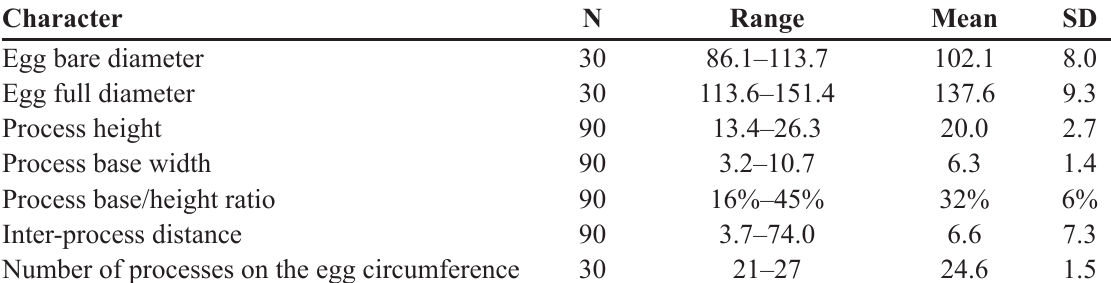
Table 8. Measurements (in µm) of selected morphological structures of the eggs of Macrobiotus cf. recens Cuénot, 1932 from the Canary Islands mounted in Hoyer’s medium. (N = number of eggs / structures measured; Range = the smallest and the largest structure among all measured